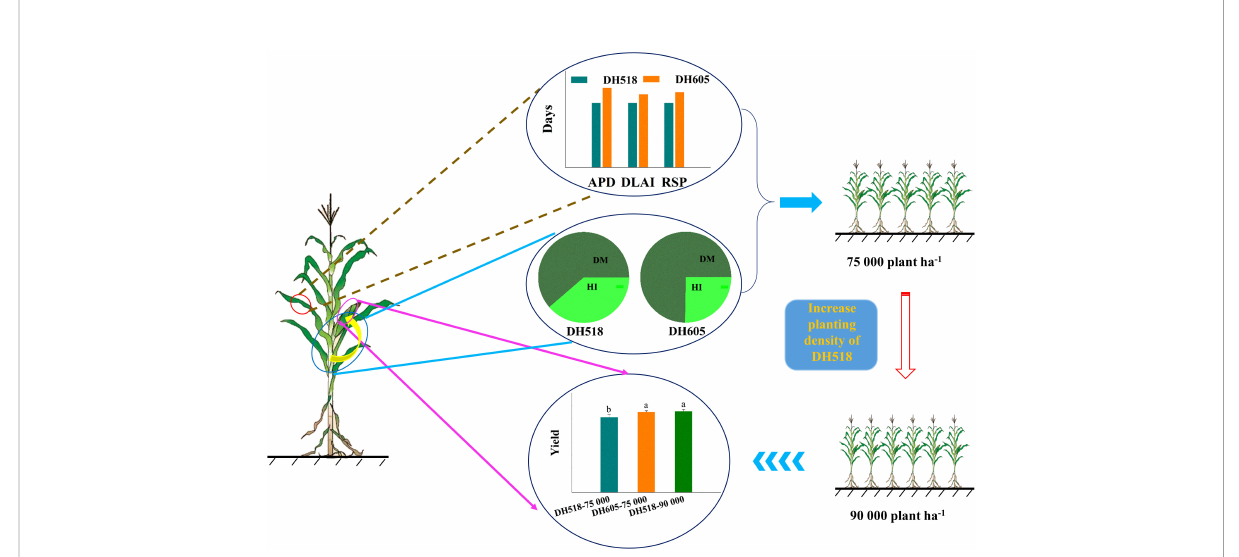
FIGURE 6 Grain yield, photosynthetic characteristics and contribution of dry matter accumulation and harvest index to yield of summer maize hybrids with different growth duration. The shortening of active photosynthesis duration, the duration of higher LAI and chlorophyll relative steady phase of early-maturing hybrids reduced the post-silking utilization ef fi ciency of light and temperature resources and negatively affected the yield. Increasing planting density of early-maturing hybrids and increasing dry matter accumulation of population could signi fi cantly increase yield, and there was no signi fi cant difference between early-maturing hybrids and middle-late maturing hybrids. DH518, Denghai518; DH605, Denghai605. ADP, active photosynthesis duration; DLAI, the duration of higher LAI; RSP, chlorophyll relative steady phase. Different letters on bars indicate signi fi cant differences among treatments at p < 0.05 using LSD